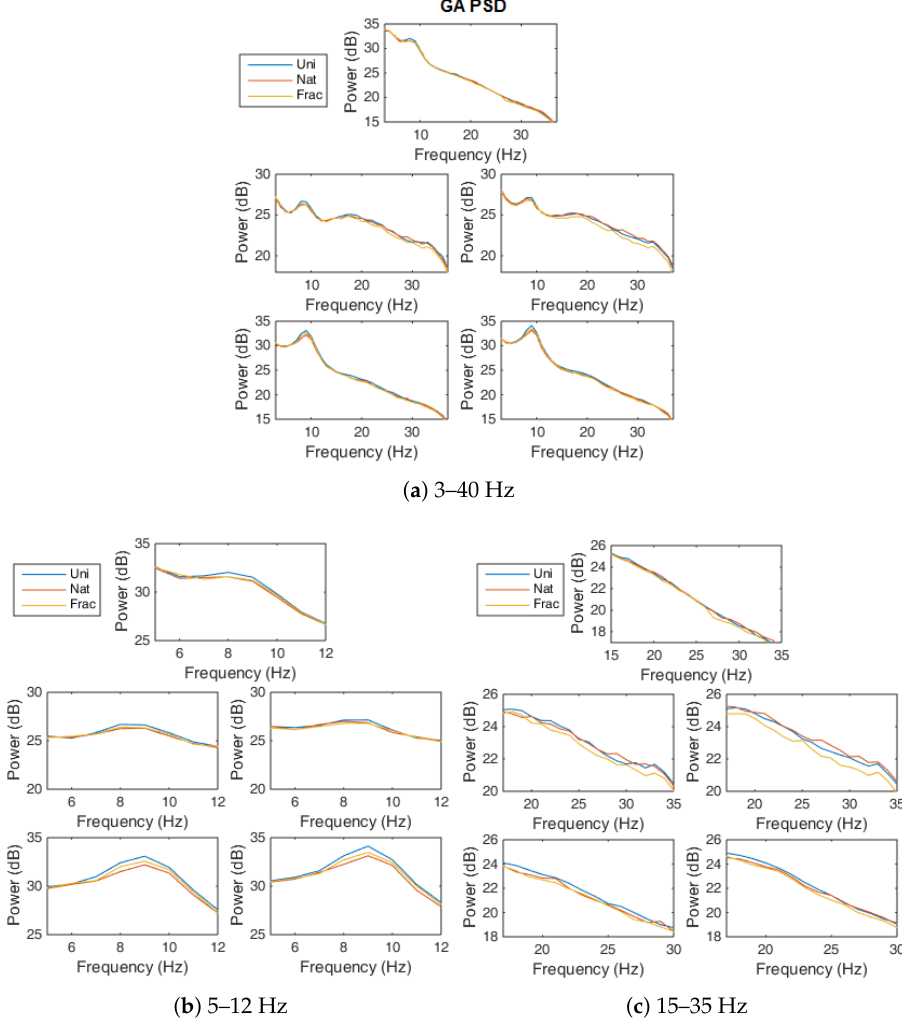
Figure 8. GA Power Spectrum over all blocks, for Uni (blue), Nat (red) and Frac images (orange), for all channels,